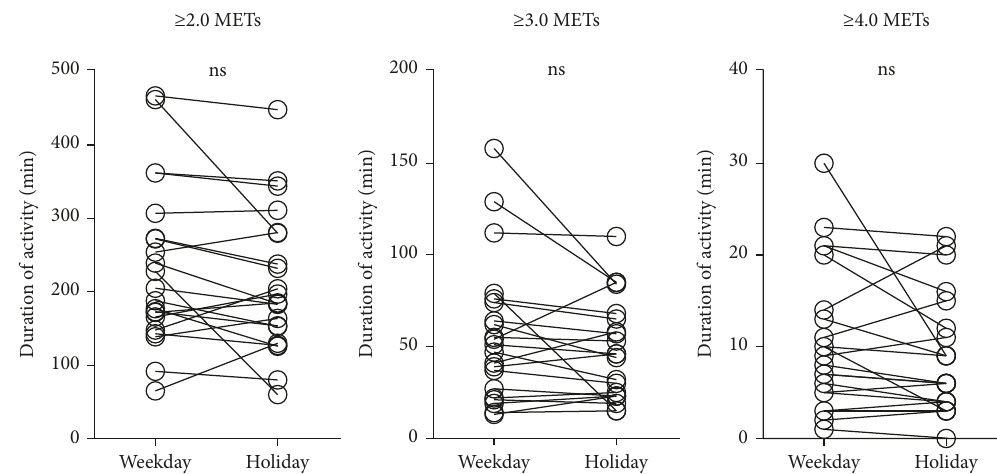
Figure 3: Effect of holidays on the duration of PA. METs: metabolic equivalents; PA: physical activity.